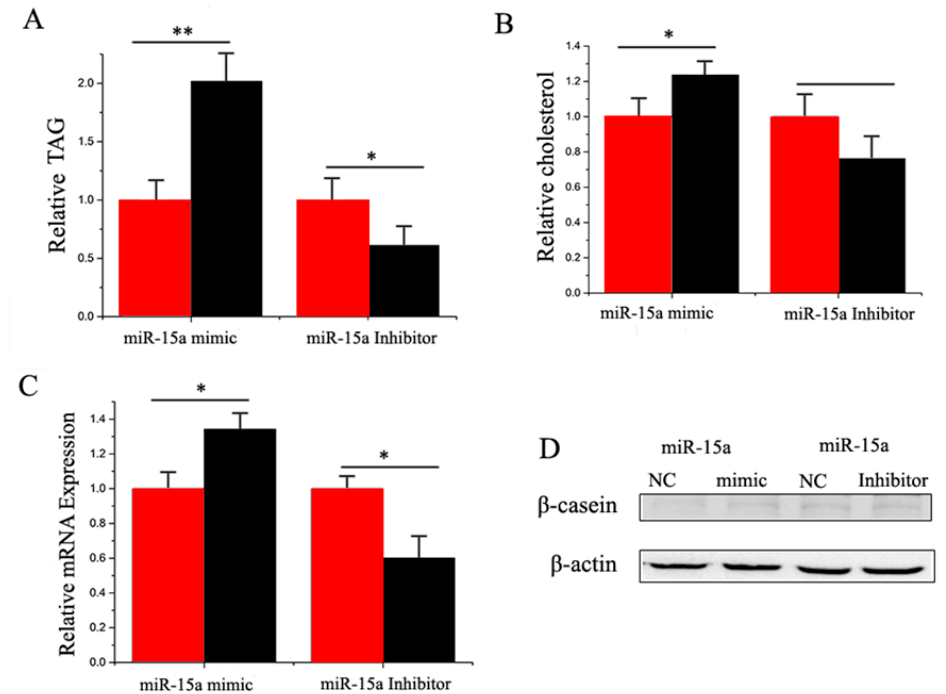
Figure 6. ( A ) Triglyceride levels in cells transfect with miR-15a mimic or inhibitor; triglyceride levels in transfected cells were compared with that of miR-15a controls ( n = 6). Red bars represent the negative control; black bars represent miR-15a mimic or inhibitor; ( B ) Cholesterol levels in transfected cells were compared with that of control ( n = 6). Red bars represent the negative control; black bars represent miR-15a mimic or inhibitor; ( C ) The expression of β -casein was quantified by RT-qPCR ( n = 6); ( D ) The effect of miR-15a mimic or inhibitor on β -casein protein expression was evaluated by Western blot in GMEC. Total protein was harvested 48 h post-treatment, respectively. All experiments were duplicated and repeated three times. Values are presented as means ± standard errors, * p < 0.05; ** p < 0.01.